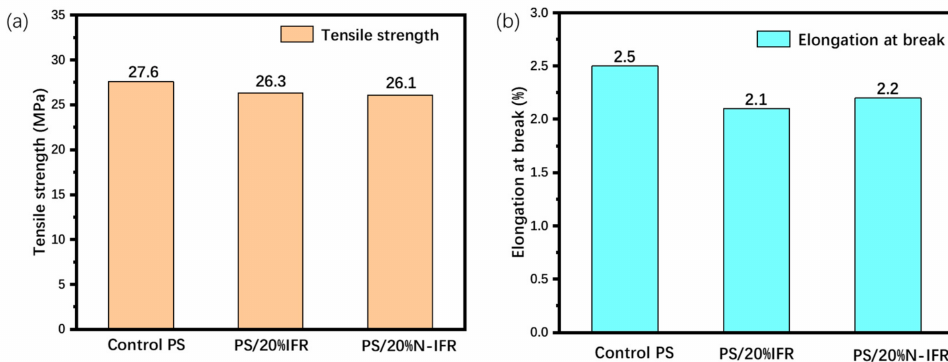
Figure 6. Tensile strength test diagram ( a ) and elongation test diagram ( b